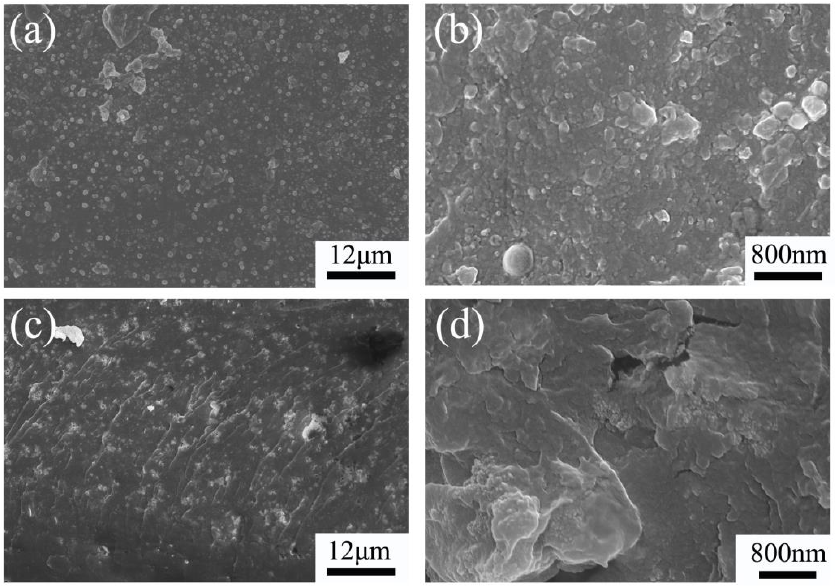
Figure 4. ( a , b ) the surface and ( c , d ) cross-sectional SEM images of hybrid membranes at different magnifications.